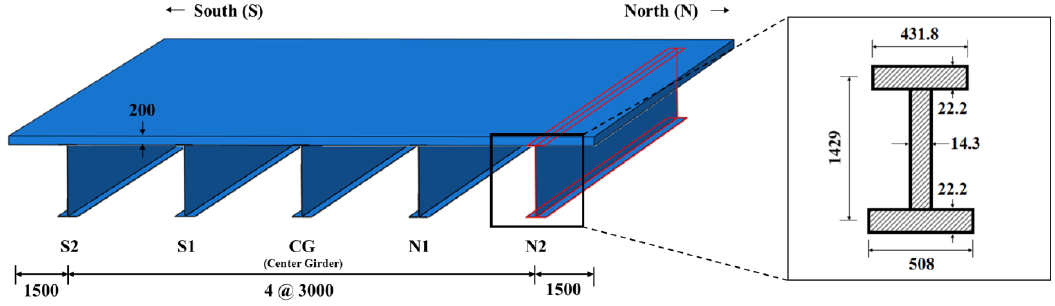
Figure 9. Dimensions of the bridge (Unit: mm).